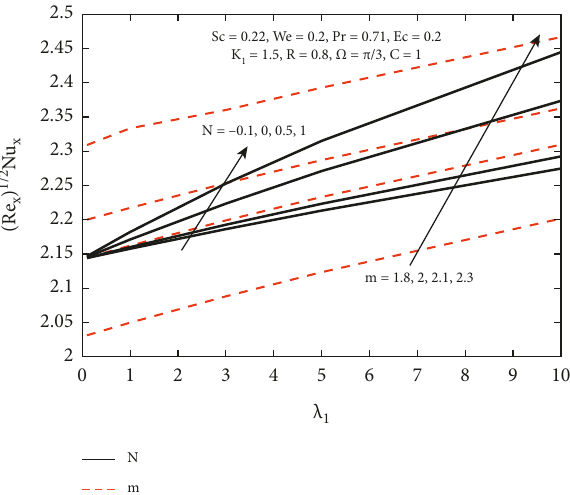
for increasing values of Sc and We. f (cid:27)(cid:27)(cid:27) (cid:26)